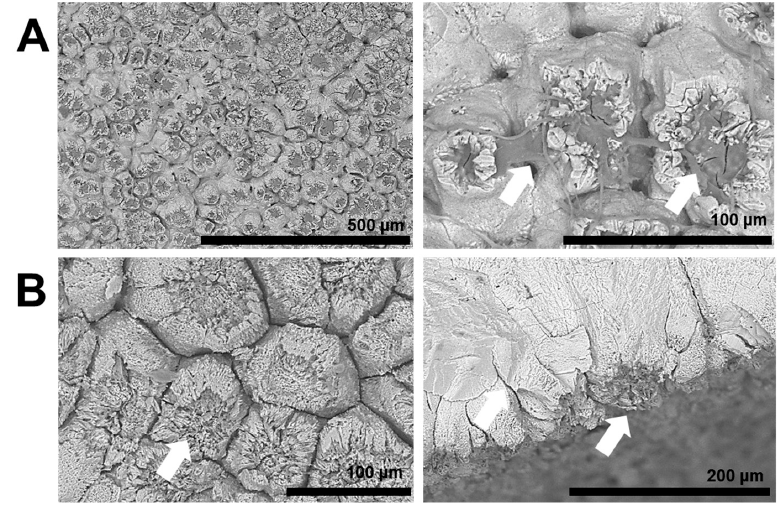
Figure 1. Representative SEM images of inner surfaces of the egg shell ( A ) before and ( B ) after calcination. Arrows indicate ( A ) co-association of mammillae content with the palisade base and ( B ) high porosity of the palisade cone after calcination.